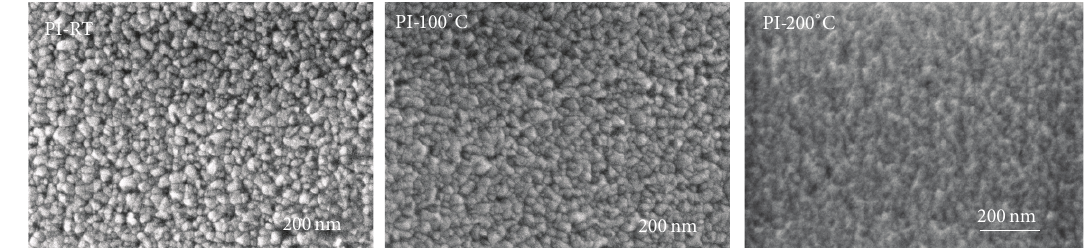
Figure 3: Surface observations of the GZO thin films as a function of substrate temperature.